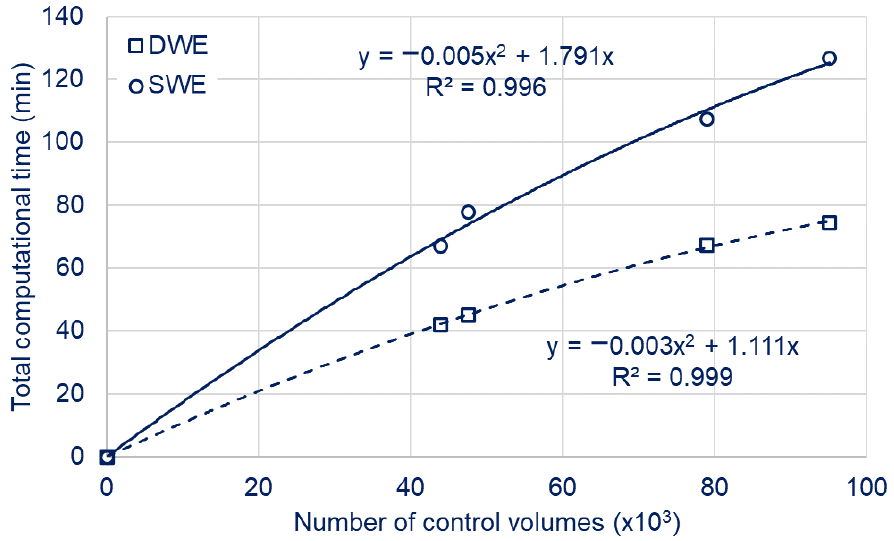
Figure 9. Comparison of total computational time to number of control volumes for scenarios DWE-4 and SWE-4.